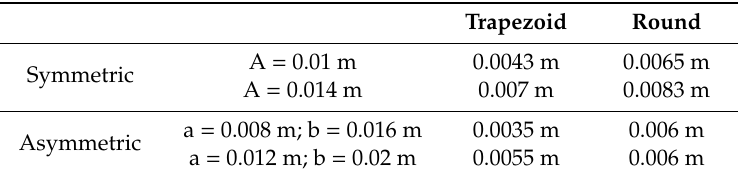
Table 2. The distance from middle chamber to neutral axis.